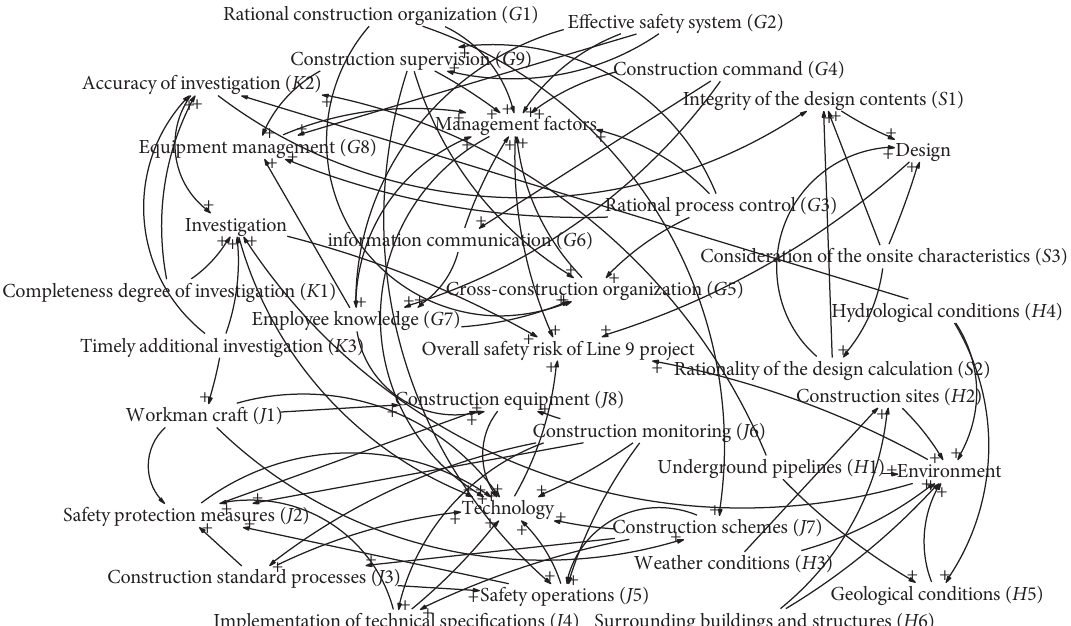
Figure 4: Causal loop diagram considering all the risk